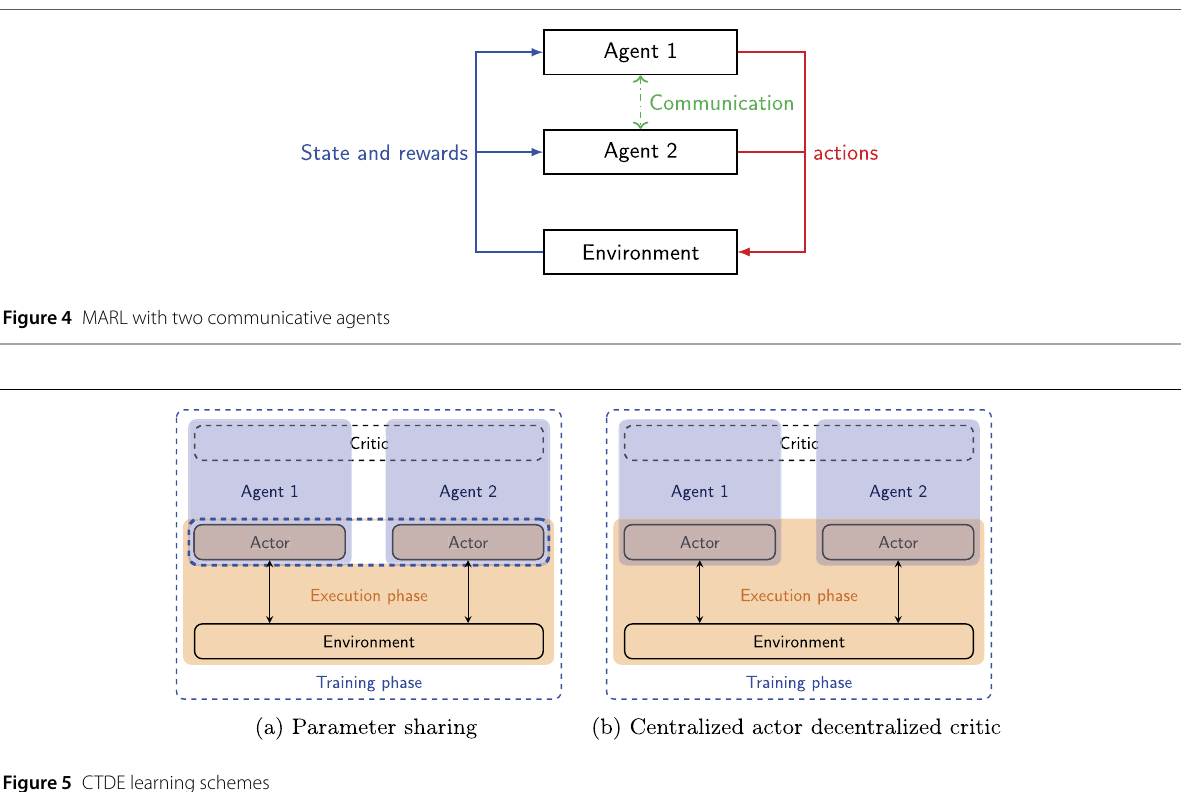
Figure 5 CTDE learning